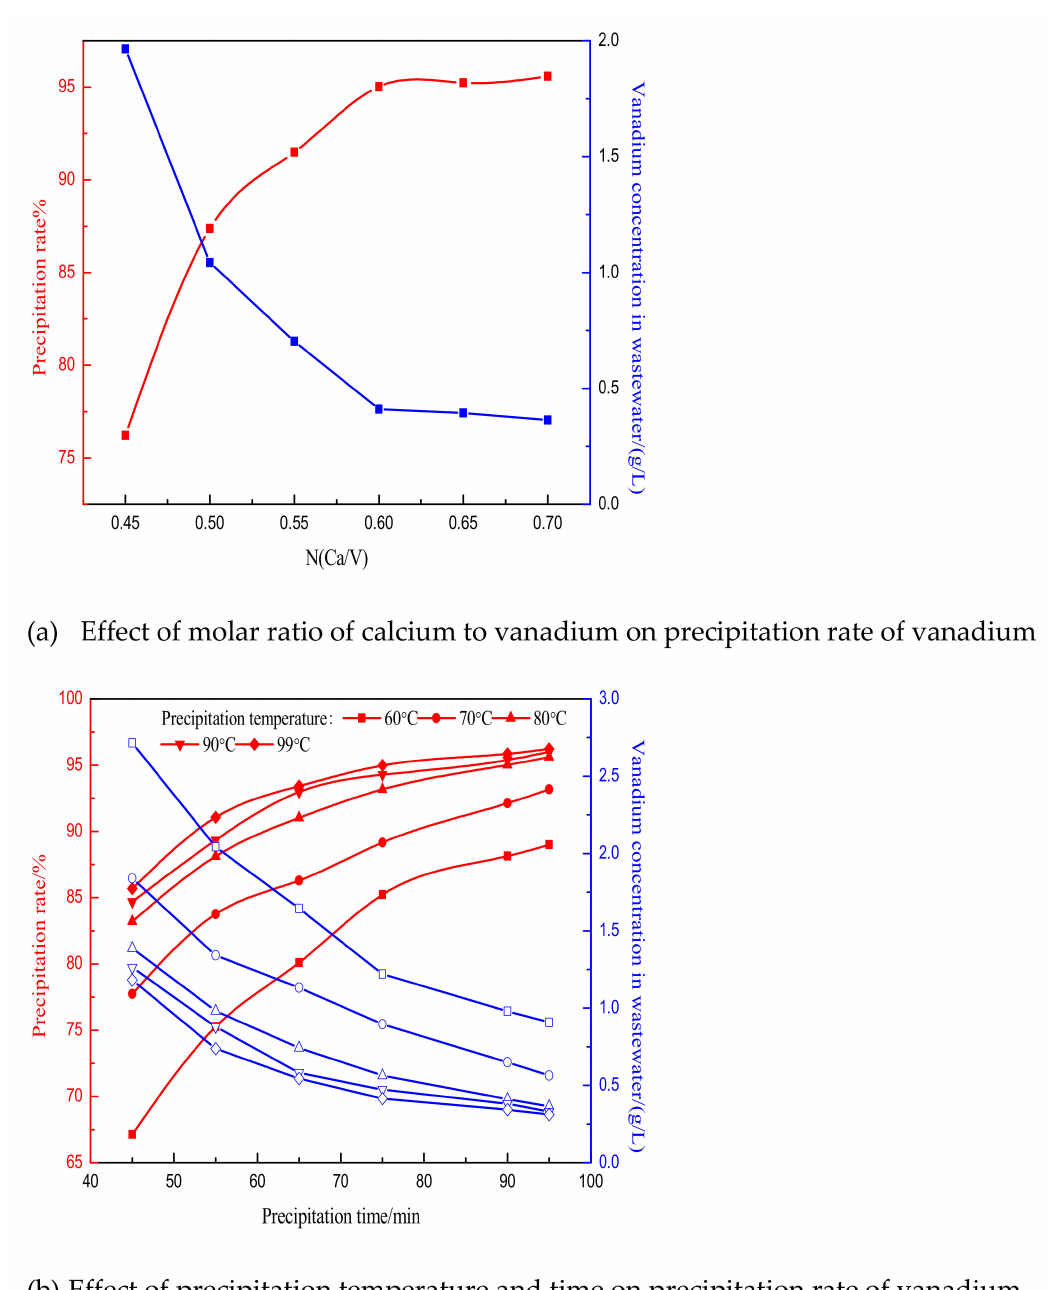
Figure 9. The effects of N(Ca)/n(V), precipitation temperature, and precipitation time on the vanadium precipitation ratio and vanadium concentration in the vanadium